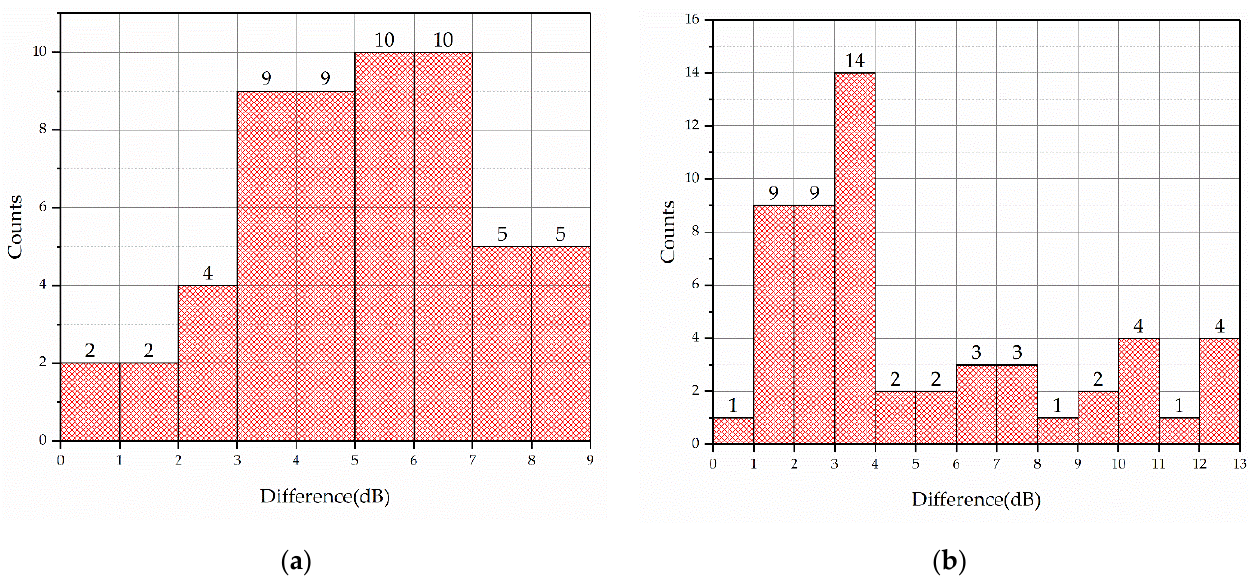
Figure 17. Difference statistics between FUVH and its four units: ( a ) the difference of X channel and ( b ) Y channel.